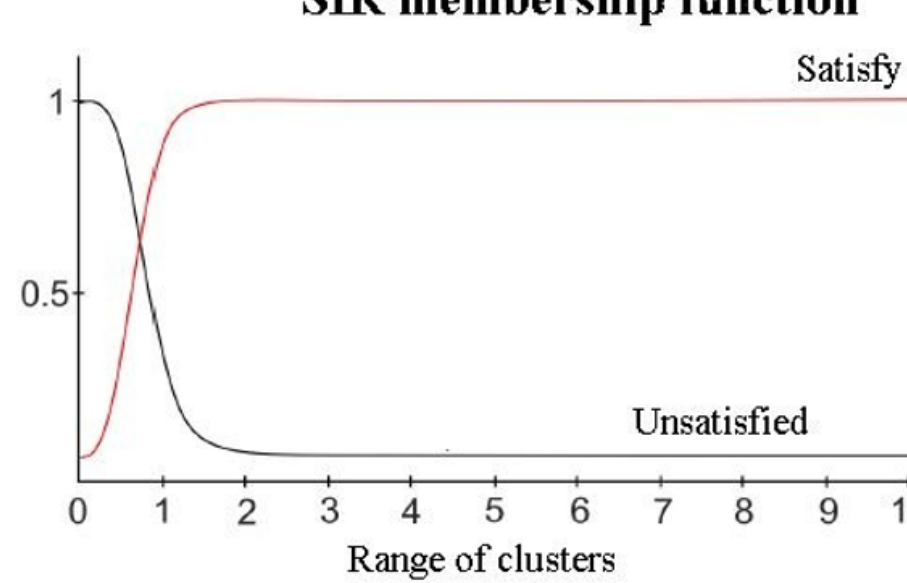
Figure 11. Signal interference ration (SIR) membership function in fuzzy logic.